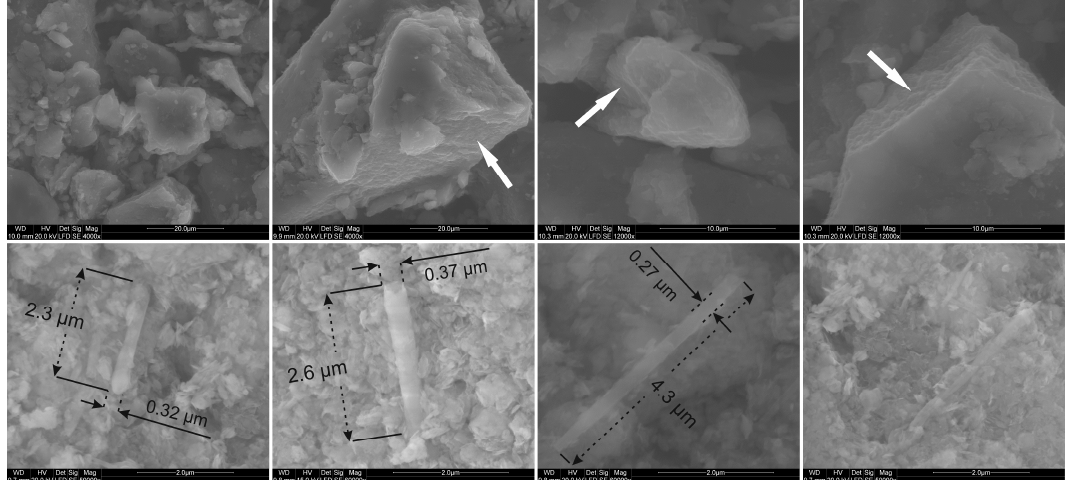
Figure 2. FTIR spectra of halloysite sample H, LDH and H-LDH-P materials in the ( a ) 3800–2600 cm − 1 range and ( b ) 2000–400 cm − 1 range.